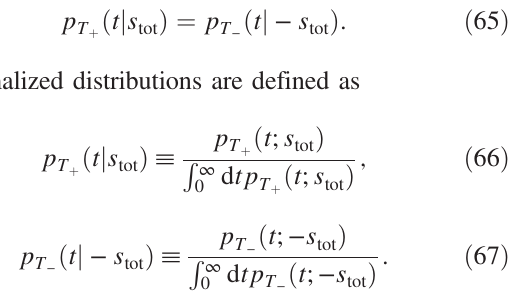
FIG. 3. Illustration of the first-passage times for entropy 1 Þ production. (a) First-passage time T ð for entropy production þ with one positive absorbing boundary s (top) and first-passage tot time T ð 1 Þ − for entropy production with one negative absorbing 2 Þ boundary − s (bottom). (b) First-passage times T ð and T ð 2 Þ − for tot þ . At entropy production with two absorbing boundaries at (cid:4) s tot 2 Þ the time T ð , entropy production passes the threshold s for the tot þ first time without having reached − s before. At the time T ð 2 Þ − , tot entropy production passes the threshold − s for the first time tot without having reached s tot